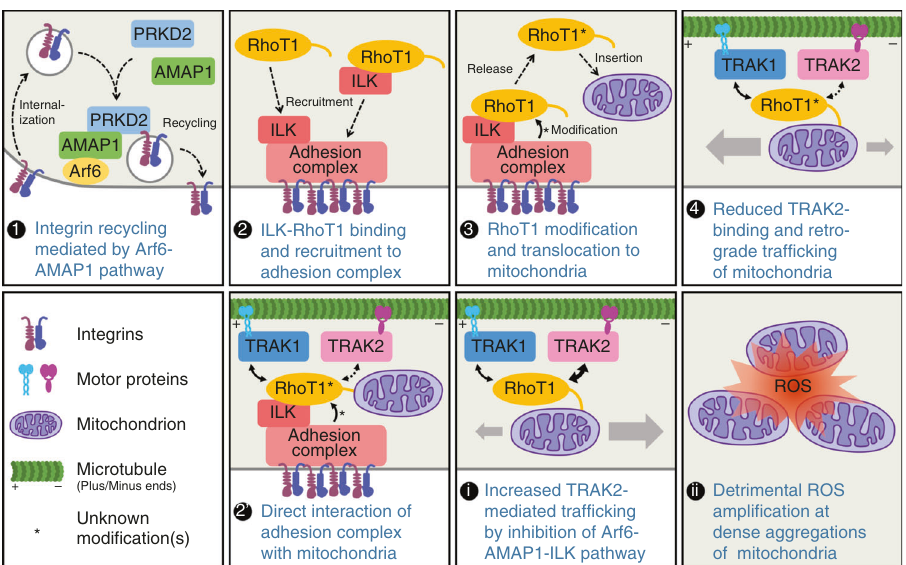
Fig. 8 A schematic model of mitochondrial distribution regulated by the Arf6 – AMAP1 – ILK pathway. Integrin recycling mediated by the Arf6 – AMAP1 pathway, which is activated in invasive cancer cells, is essential for the formation of mature FAs (1). The ILK – RhoT1 complex formed at or recruited to FAs (2) might interact with some component(s) of the adhesion complex, which causes alteration of the molecular properties of RhoT1. RhoT1 modi fi ed as such would be released and inserted into the mitochondrial outer membrane (3), and negatively regulates the interaction between RhoT1 and TRAK2, leading to relatively increased anterograde traf fi cking of mitochondria (4). Another possibility is that RhoT1 anchored to the mitochondrial outer membrane may interact with ILK, which is diffusely localized in the cytoplasm, and the above modi fi cation(s) may occur when mitochondria reach in close proximity to the mitochondria (2 ′ ). Disruption of these mechanisms reduces invasiveness and enhances the molecular interaction between RhoT1 and TRAK2, which preferentially mediates mitochondrial retrograde traf fi cking (i). The mitochondrial aggregation that is thus caused tends to result in ROS ampli fi cation via